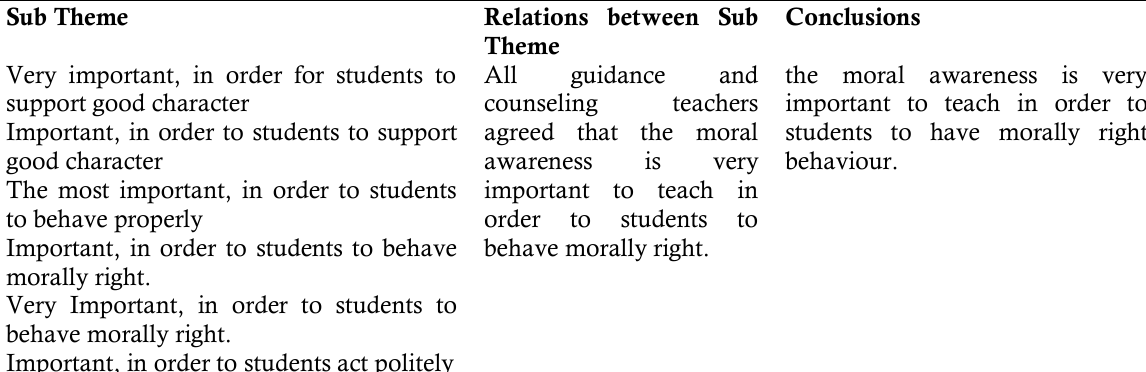
Table 1 . The Urgency of Students’ Moral Awareness